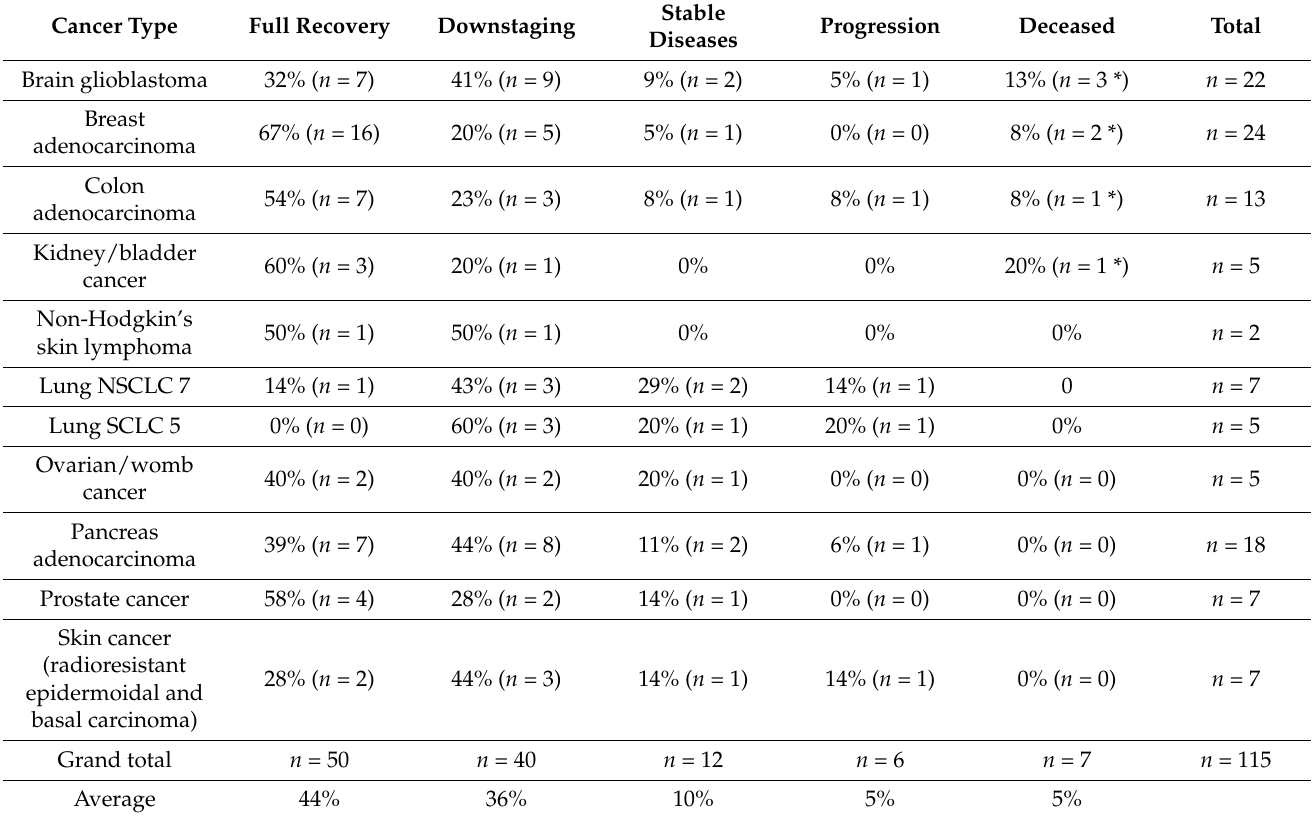
Table 2. Clinical outcomes in cancer patients treated with HOO (follow-up 4